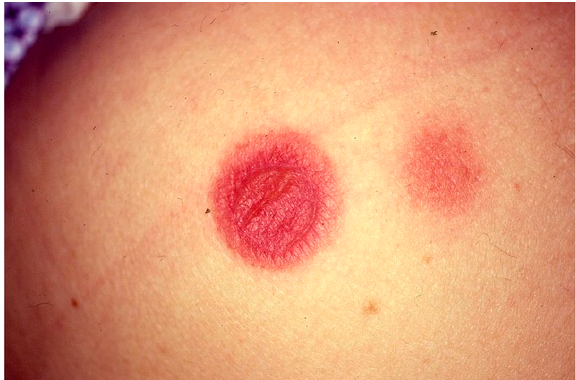
Figure 5. Clinical manifestations of fixed drug eruption characterized by sharply demarcated erythematous-violaceous and oval patches.